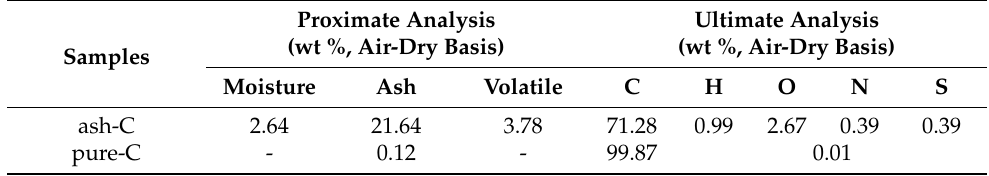
Table 1. Proximate and ultimate analyses of the graphite (wt.%).